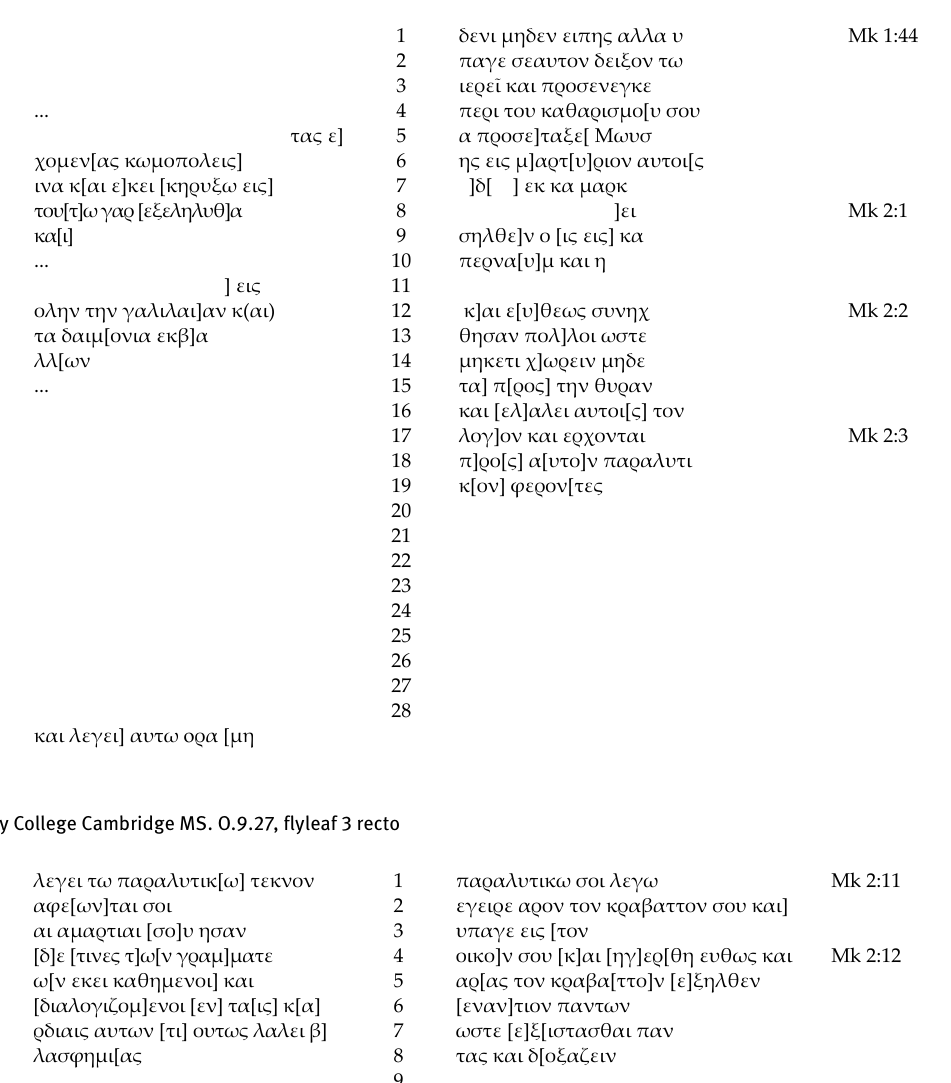
Table 1. Trinity College Cambridge MS. O.9.27, flyleaf 3 verso